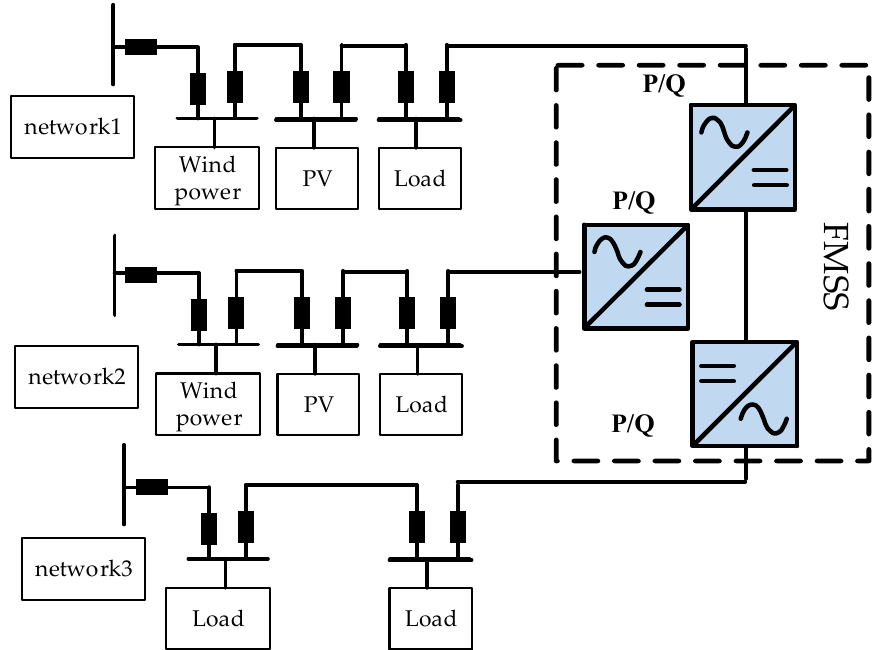
Figure 6. A scenario of the distribution network with three-terminal flexible multi-state switches. Table 1. Access location and rated power of DG.